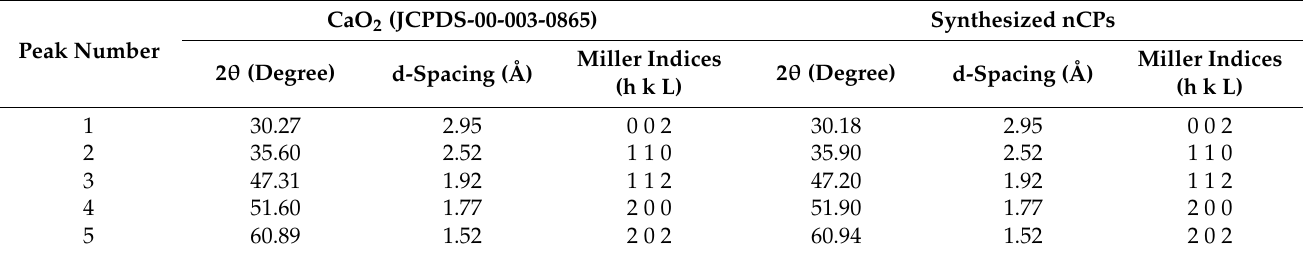
Table 2. Comparison of 2 θ and d-spacing values of the standard CaO 2 with the synthesized nCPs.